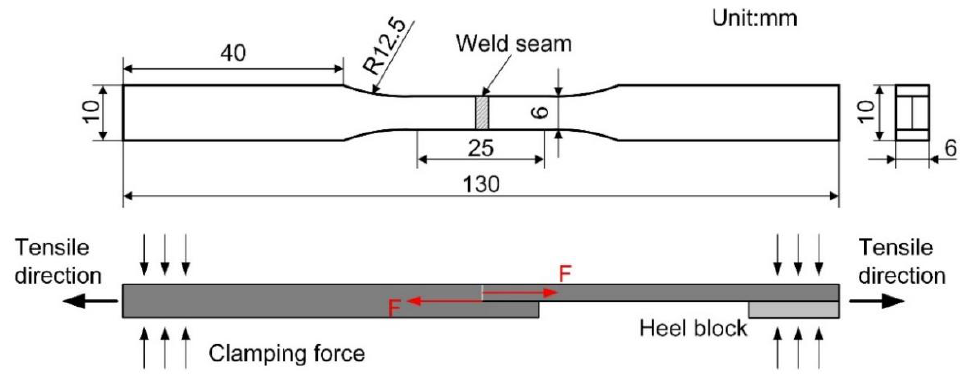
Figure 2. Schematic diagram of tensile specimens.